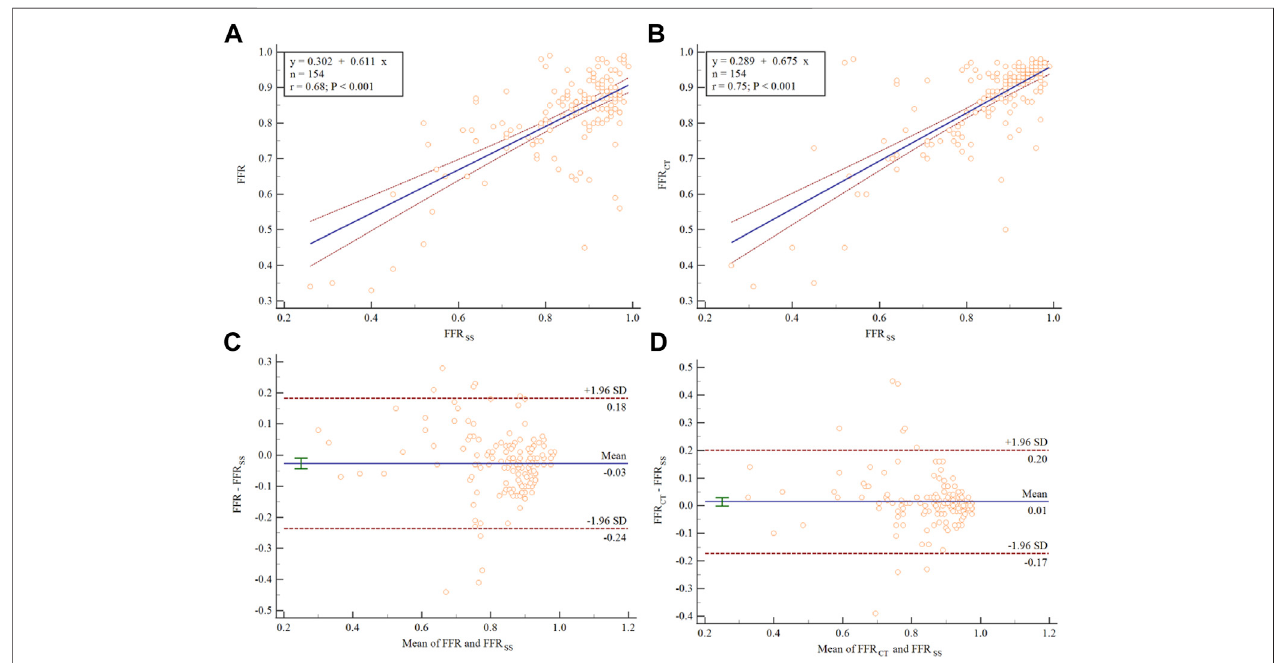
FIGURE4| ScatterplotandBland – AltmananalysisshowingthecorrelationbetweenFFR,FFR SS ,andFFR CT .Thedashedbluelinerepresentsthelineofbest fi t. (A) The correlation between FFR and FFR SS . (B) The correlation between FFR CT and FFR SS . Bland – Altman plots of differences against the means are displayed for (C) FFR SS and (D) FFR CT . The mean bias is represented by the solid blue line (with the 95% con fi dence interval represented by the dashed blue line).